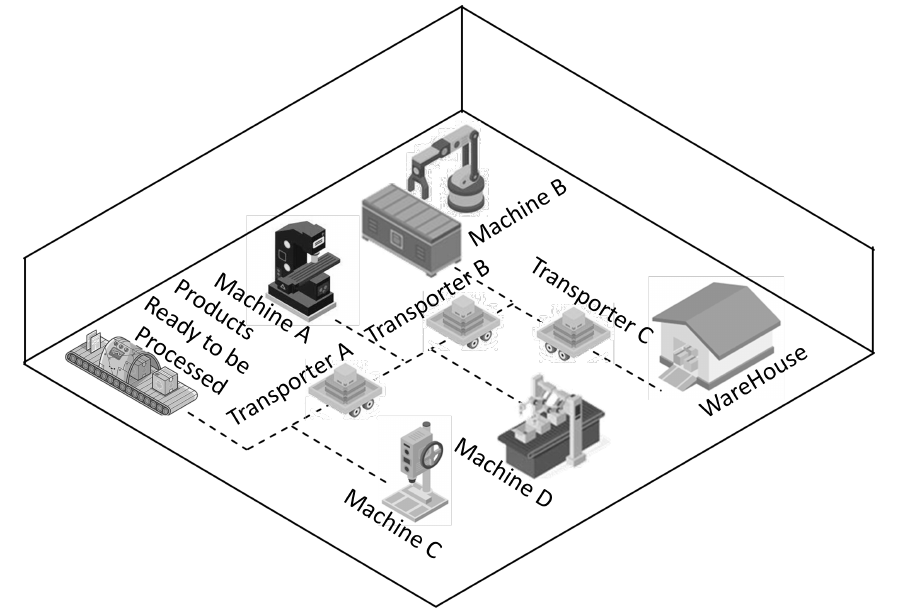
Figure 3. Example of a shop floor to be